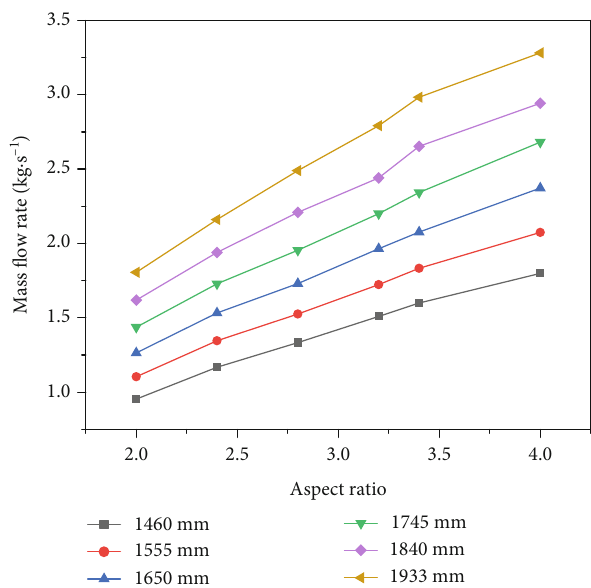
Figure 3: Fuel penalty with di ff erent aspect ratios and opening lengths at a slope angle of 6 ° .